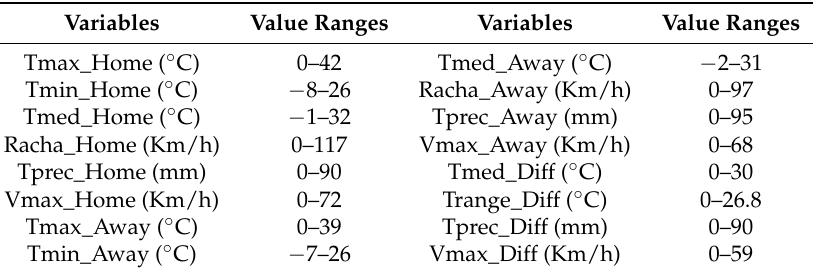
Table 1. Weather variables and corresponding value ranges.